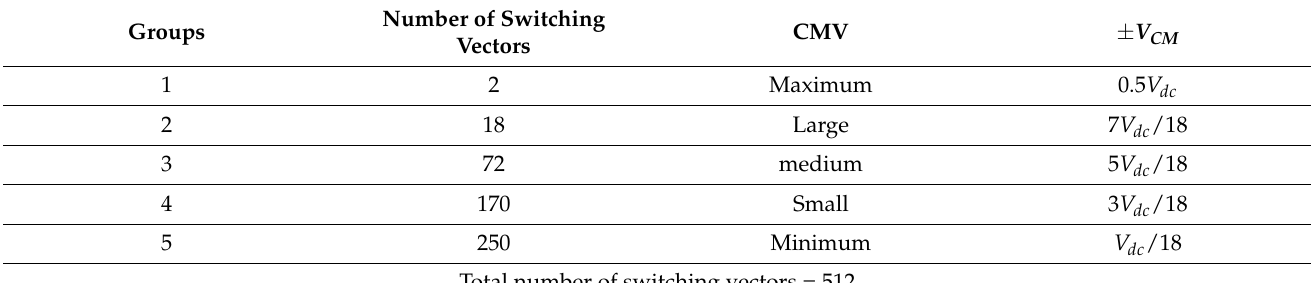
Table 3. Classification of the switching vectors for nine-phase VSI based on the corresponding peak